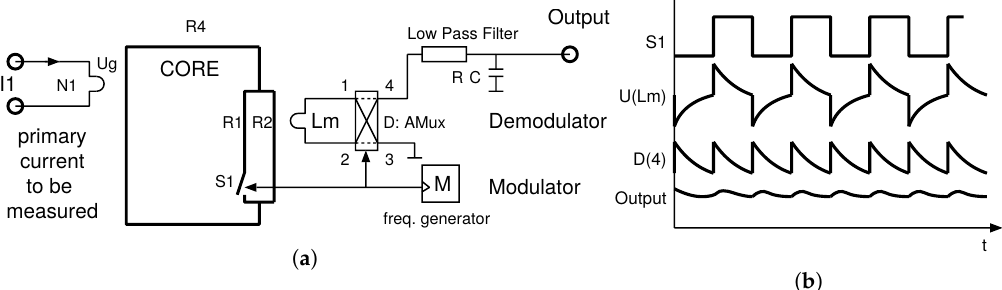
Figure 6. Concept of the Platiše Flux Sensor DC measurement. ( a ) Block diagram; ( b ) Waveform